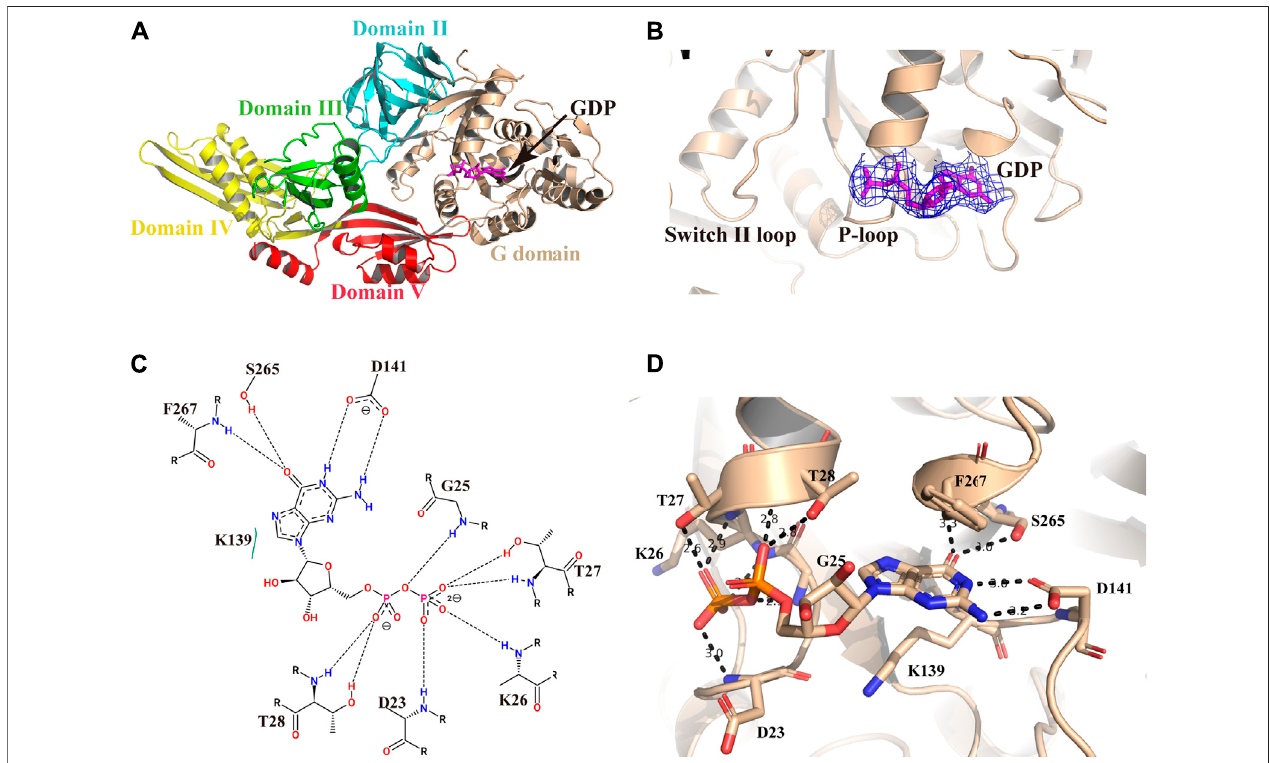
FIGURE2| StructureofMtbEF-G1incomplexwithGDP. (A) CartoonrepresentationofMtbEF-G1coloredbydifferentdomains.ThedockingofGDPintheactive site is shown as a stick model in magenta. (B) A magni fi ed view of GDP in the active site of Mtb EF-G1, with the fi nal electron density map (2Fo-Fc, contoured at 0.8 σ ) superimposed. (C) Detailed two-dimensional diagram of the active site of Mtb EF-G1 occupied by GDP. Directed bonds between Mtb EF-G1 and GDP are drawn as dashed lines. Image generated by PoseView (https://www.zbh.uni-hamburg.de/en/forschung/amd/server/poseview.html). (D) Ribbon model of the GDP binding pocket containing GDP. Residues recognizing GDP are shown in stick model. Hydrogen bonds between Mtb EF-G1 and GDP are indicated by dashed